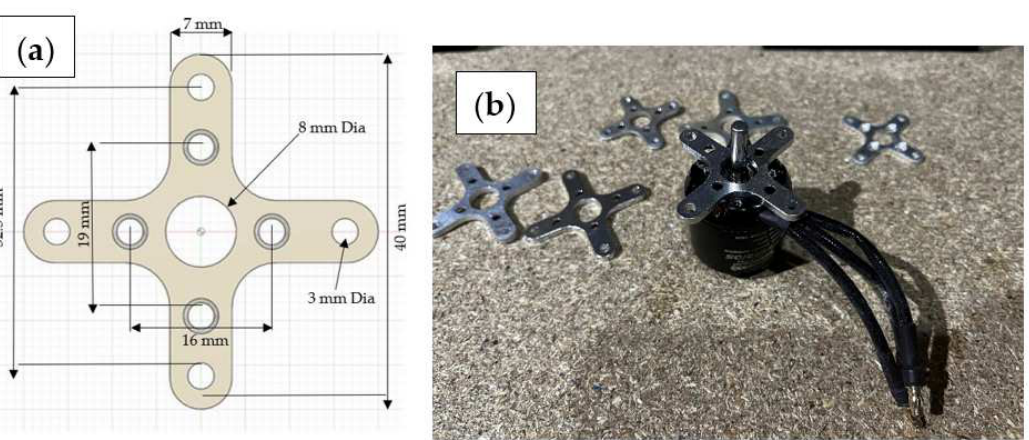
Figure 9. Original motor holder for streamliner 350 autonomous aircraft ( a ) original CAD model of the holder, ( b ) physical motor assembly with the holder.